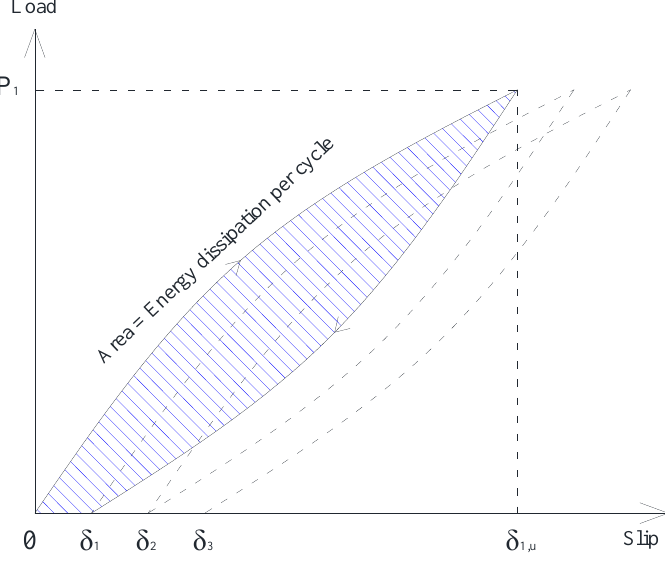
Figure 11. Calculation of energy dissipation per load cycle.